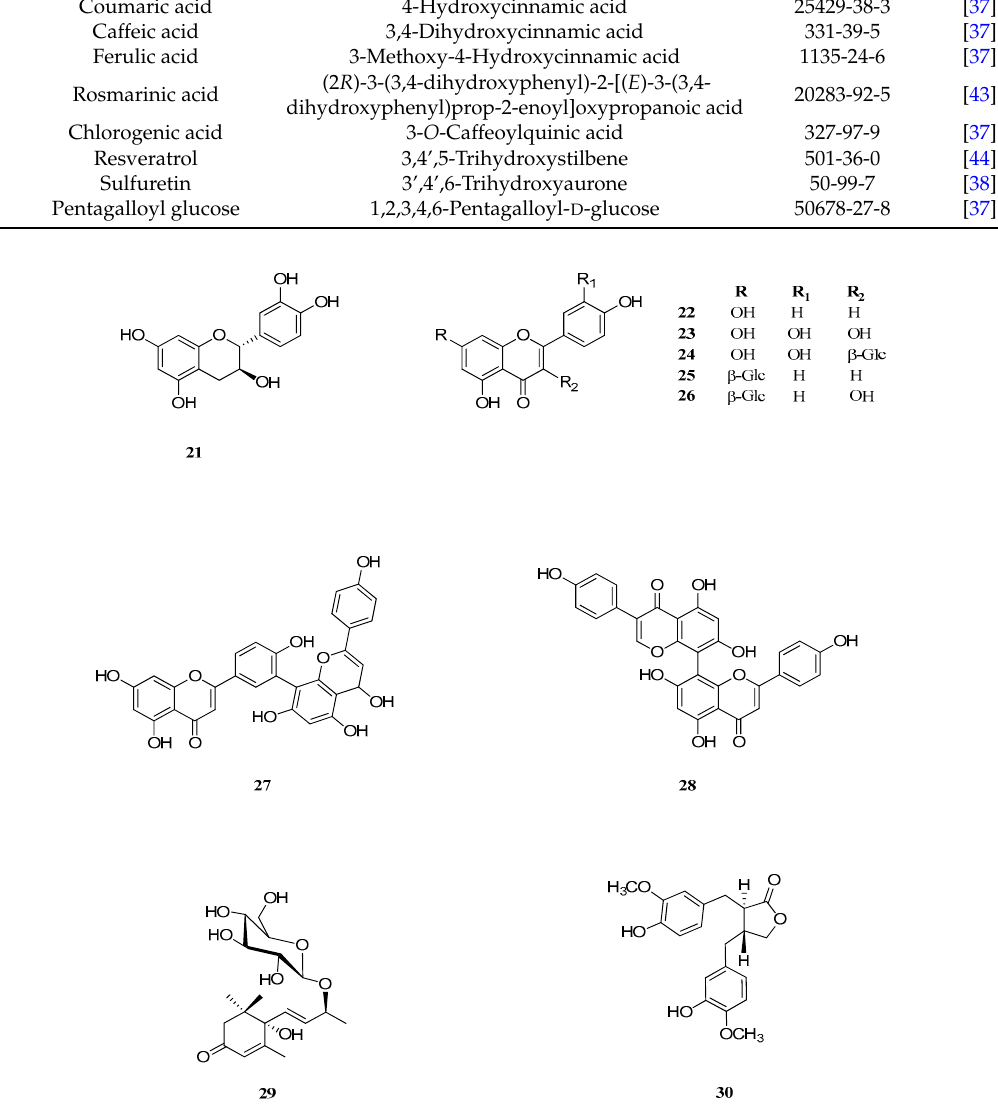
Figure A2. Chemical structures of compounds 21 – 30 isolated from J. communis .